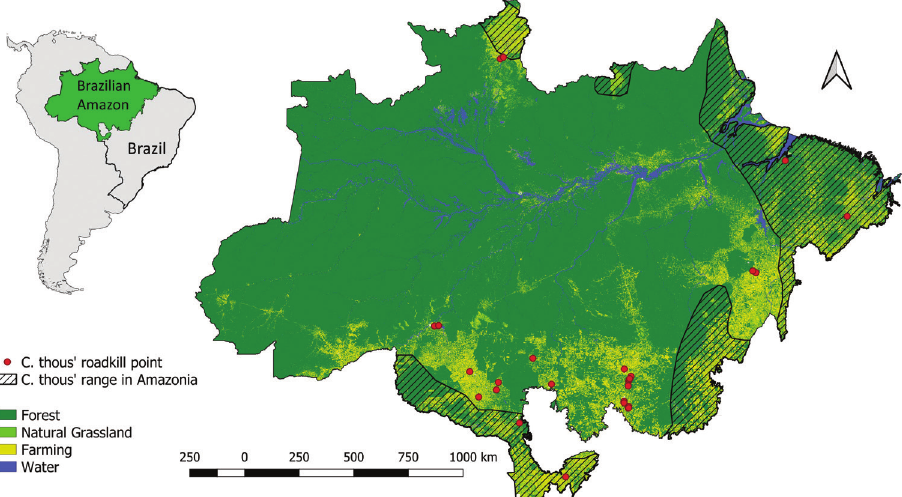
Figure 4. Roadkill records of C. thous in Amazon ecosystem. Red dots represent roadkill records of C. thous and the hashed area is the original species’ range on Amazon. It is possible to notice some registers out of the crab-eating-fox’s range according IUCN (Lucherini, 2015), specifically in areas where forests (dark green areas) were converted into farming areas (yellow